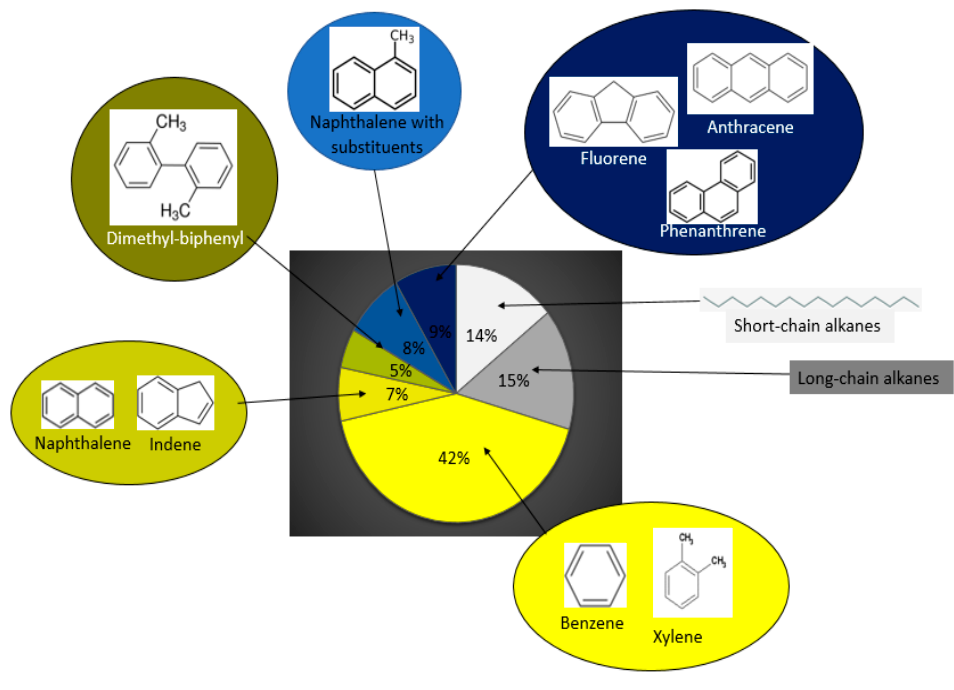
Figure 6. Composition of the used engine oil as revealed through GC / MS analysis.